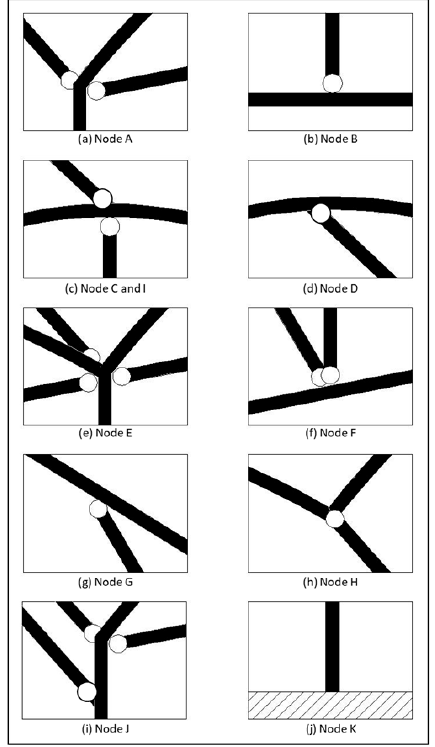
Figure 8. Close-up details of the nodes indicated in Figure 7.